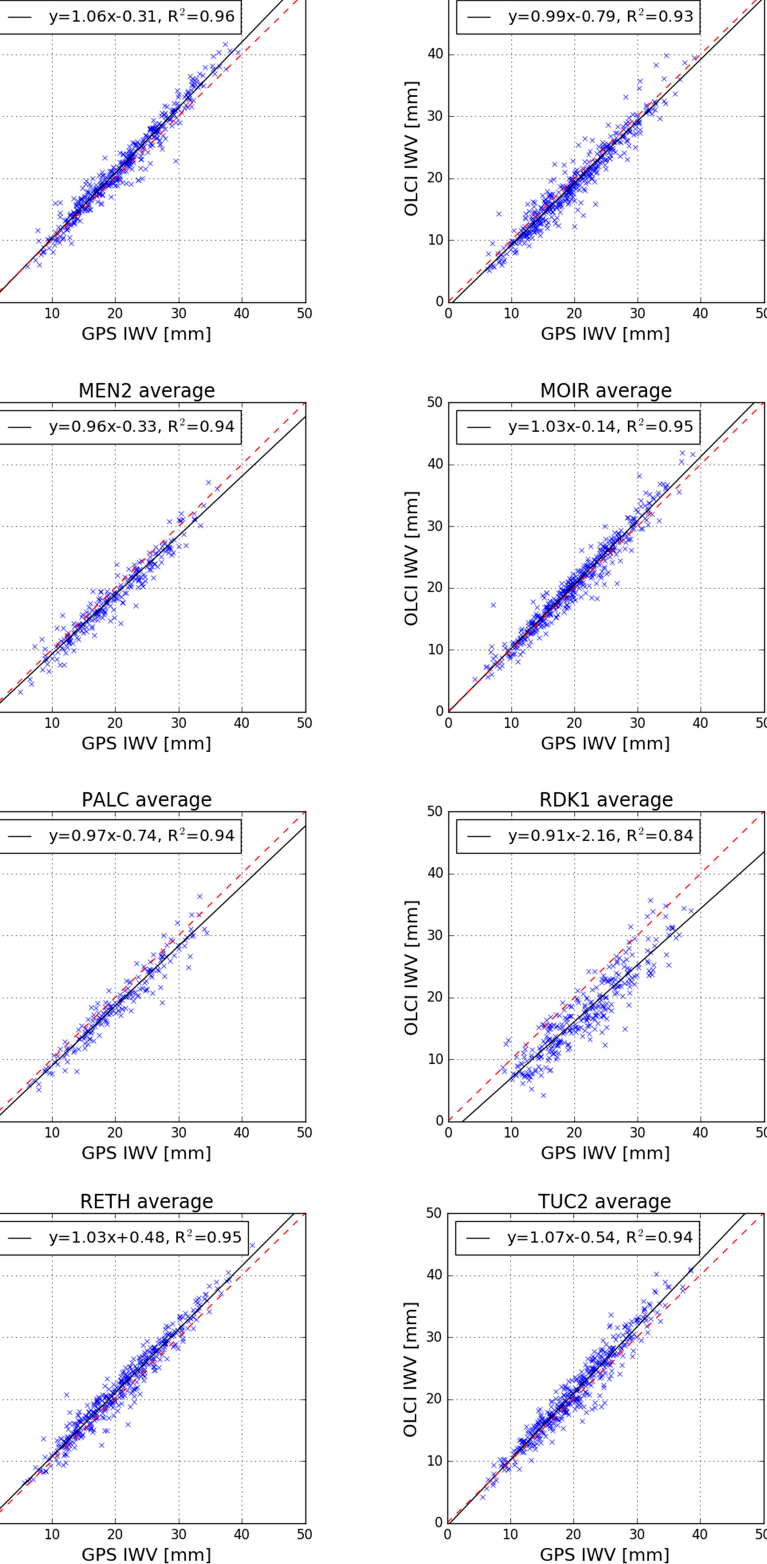
Figure 8. Scatterplots of simultaneous IWV measurements obtained by the Sentinel-3A OLCI instrument as derived by the “area of influence” approach and the GNSS station at the respective station location. Only OLCI pixels flagged as “LAND “are used to calculate the average IWV value per OLCI image. Furthermore, it has been observed that the vast majority of IWV error of valid OLCI pixels range between 0.3–2.0 mm. Pixels with IWV error larger than 2.0 mm have been excluded for the remaining analysis. The offset and trend of the linear regression lines for both OLCI retrieval approaches are presented in Table 4. The Pearson linear correlation coefficient and its significance value ( p value) is also given. It seems that significant ( p -value less than the strict arbitrary significance level of 0.003) strong (Pearson coefficient >0.80) correlation between the two datasets exists. A similar validation analysis has been carried out for the Sentinel-3B OLCI IWV values. The Sentinel-3B dataset is smaller compared to Sentinel-3A, as only one year of Sentinel-3B have been available for this work because the satellite reached its nominal orbit in late 2018. Table 4. Statistical analysis of the correlation between the Sentinel-3A OLCI and GNSS IWV values at the GNSS stations over the study area. The confidence level for regression analysis is 95% and in all cases the Pearson p -value (probability) is <0.003. Offset [mm]